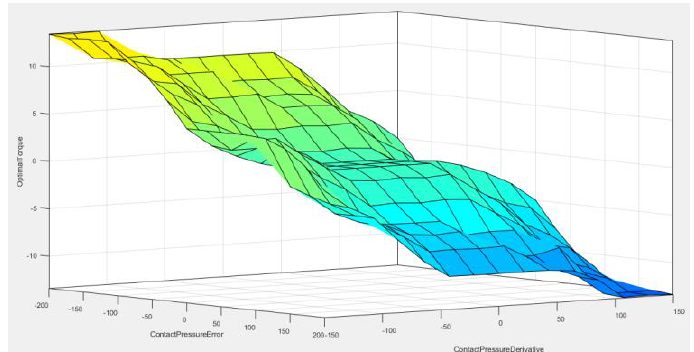
Figure 18. Surface of fuzzy controller.